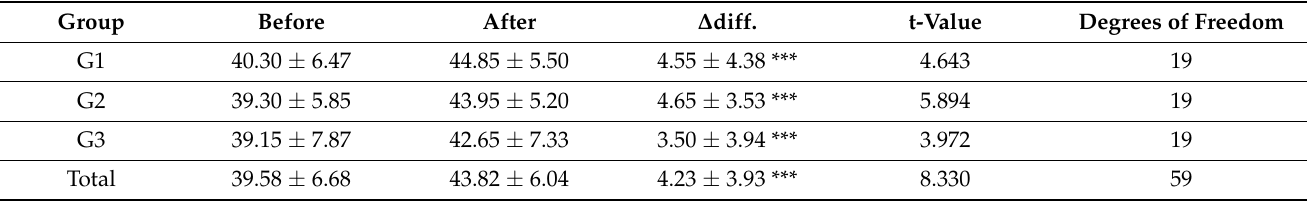
Table 7. Lumbar lordosis on the sagittal plane according to